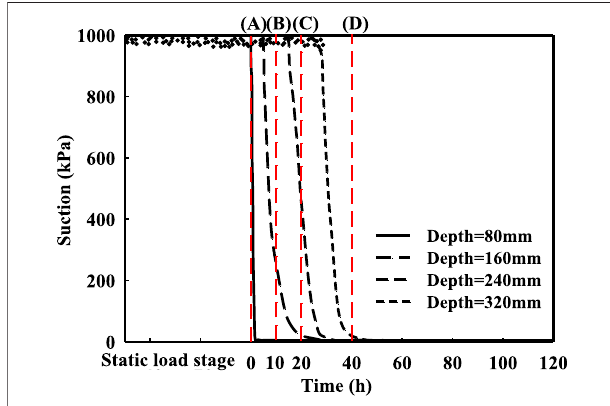
FIGURE 6 | Variations of water potential (suction) distribution with the time of PITE.